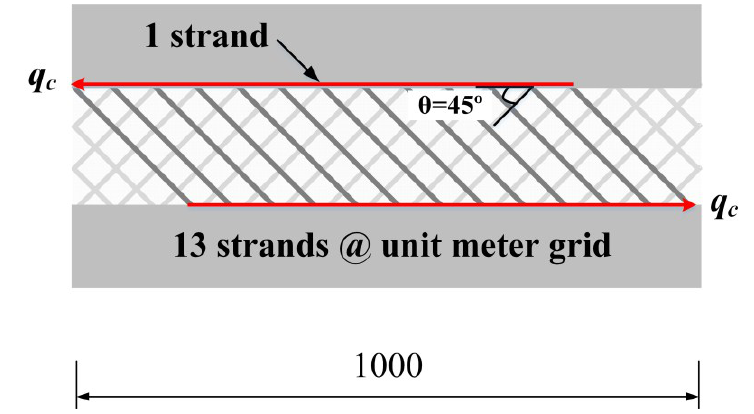
Figure 11. Shear flow strength based on the tensile strength of the GFRP